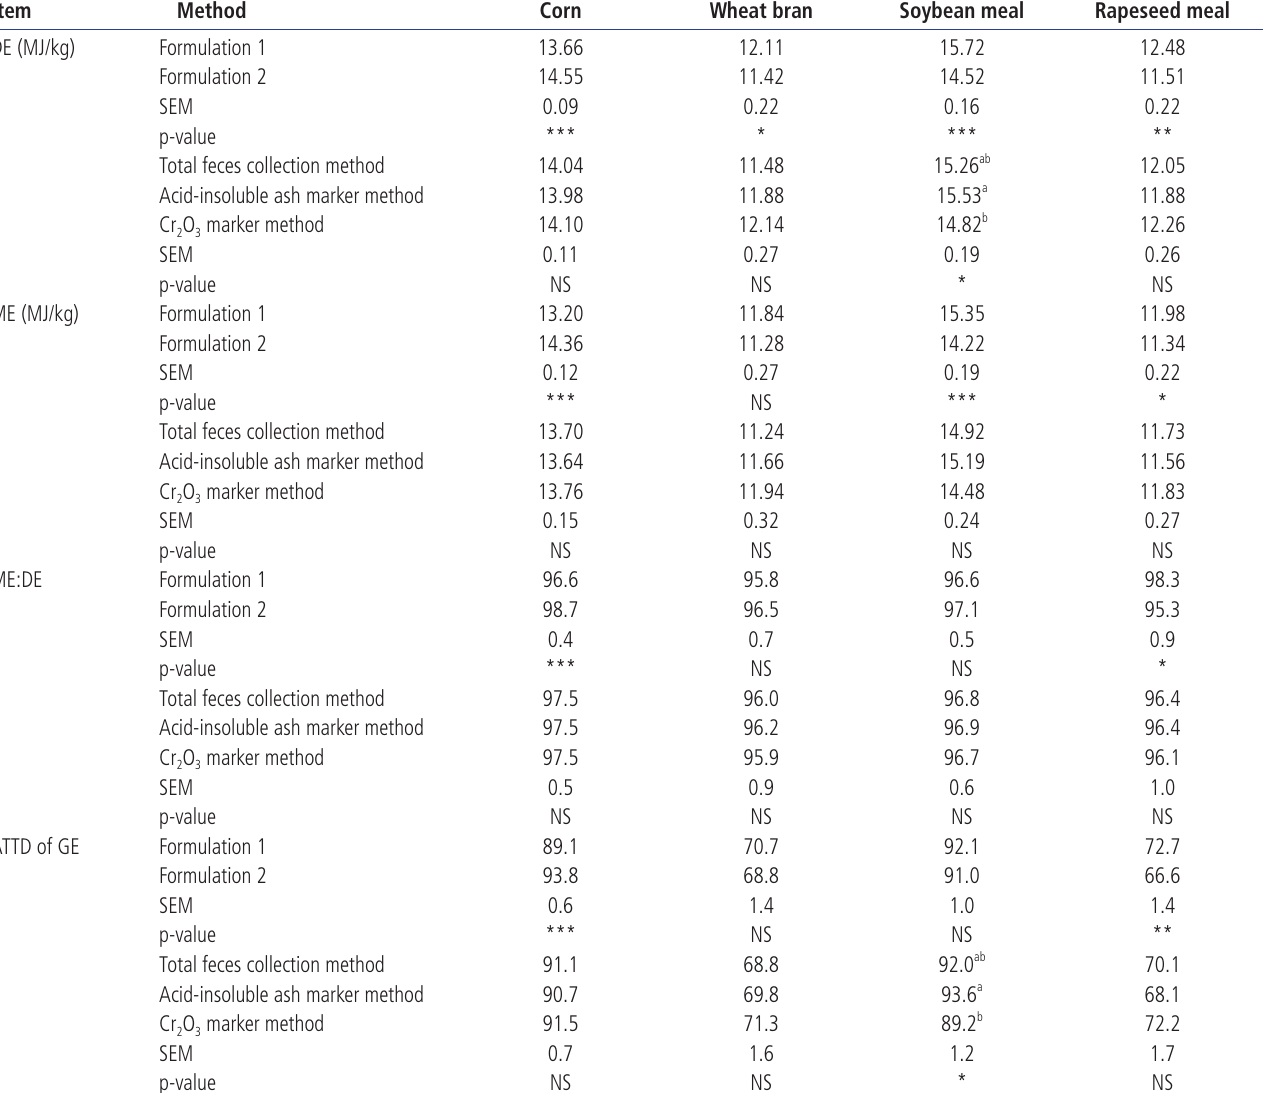
Table 8. The digestible energy (DE), metabolizable energy (ME), and the apparent total tract digestibility (ATTD) of gross energy (GE) in experimental diets fed to growing pigs (% as fed basis) 1) Item Method Corn Wheat bran Soybean